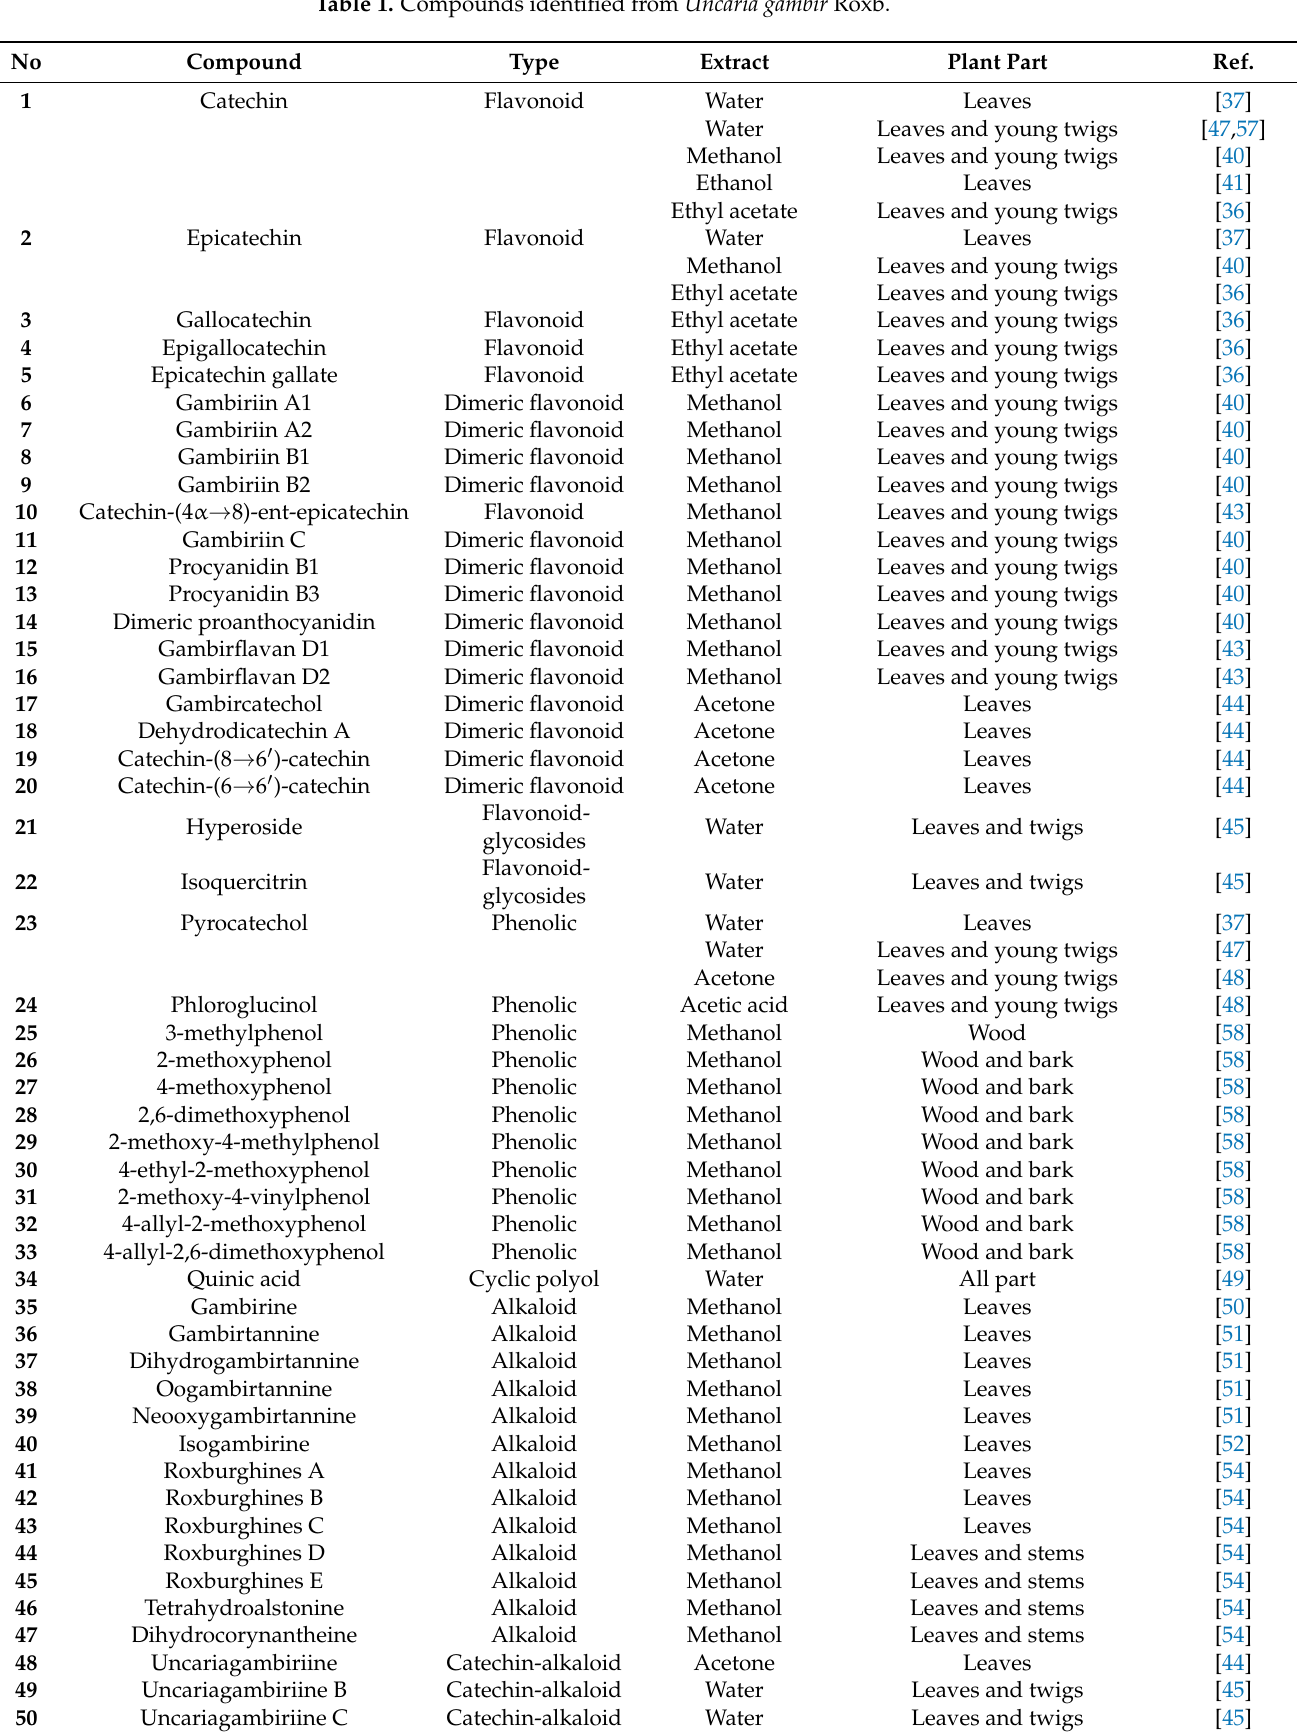
Table 1. Compounds identified from Uncaria gambir